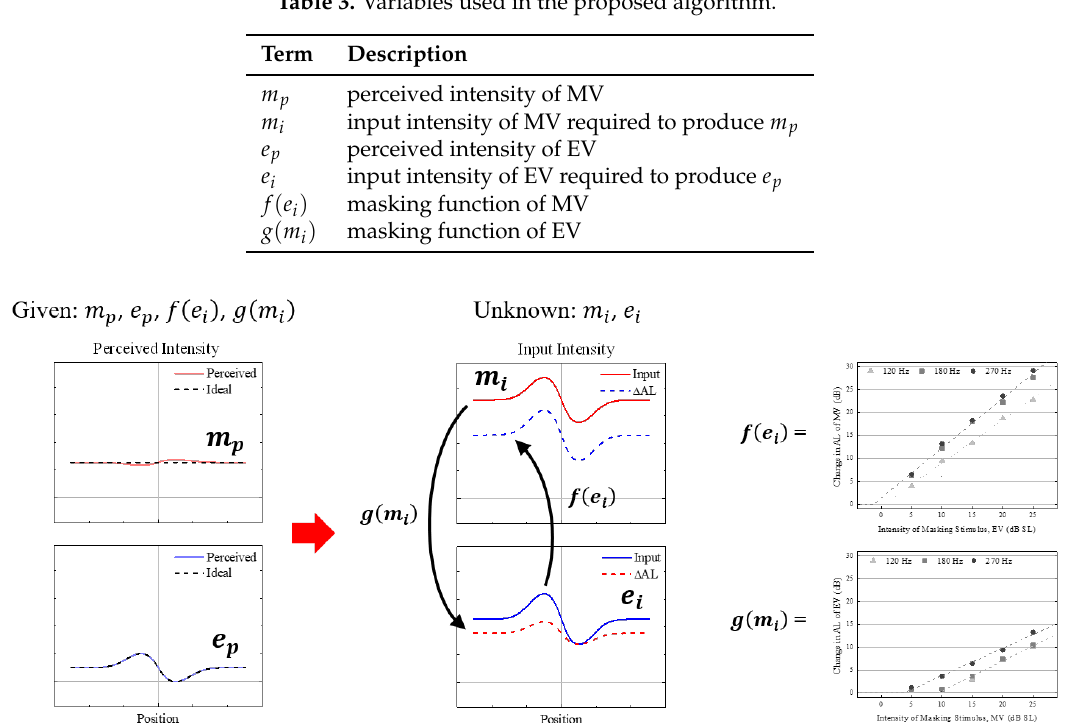
Table 3. Variables used in the proposed algorithm.